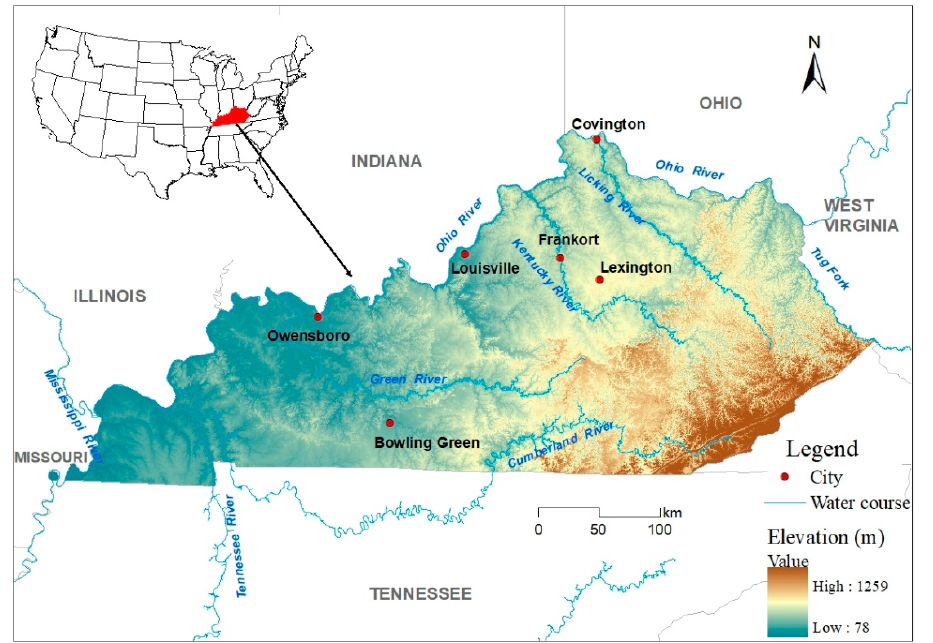
Figure 1. Spatial location of Kentucky and its topographic features.